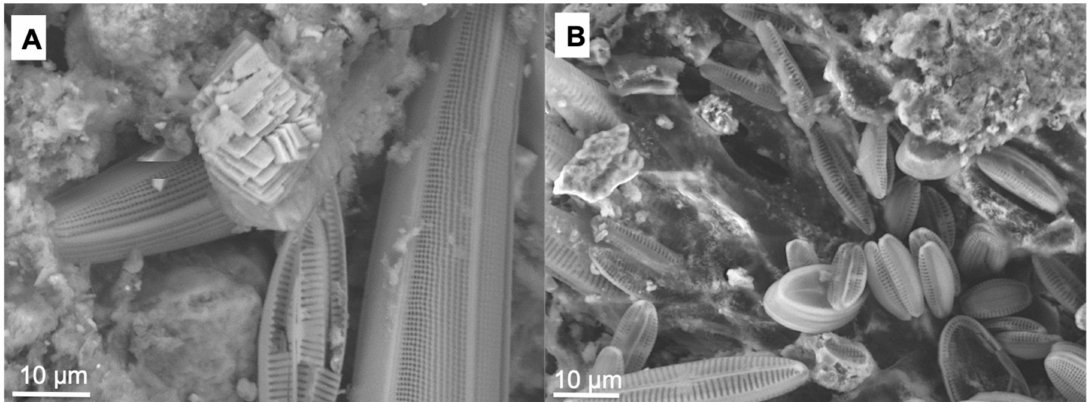
Figure 11. SEM images of ( A ) a rhombic polycrystalline sparite crystal from a natural sample and ( B ) diverse diatom species observed in a natural